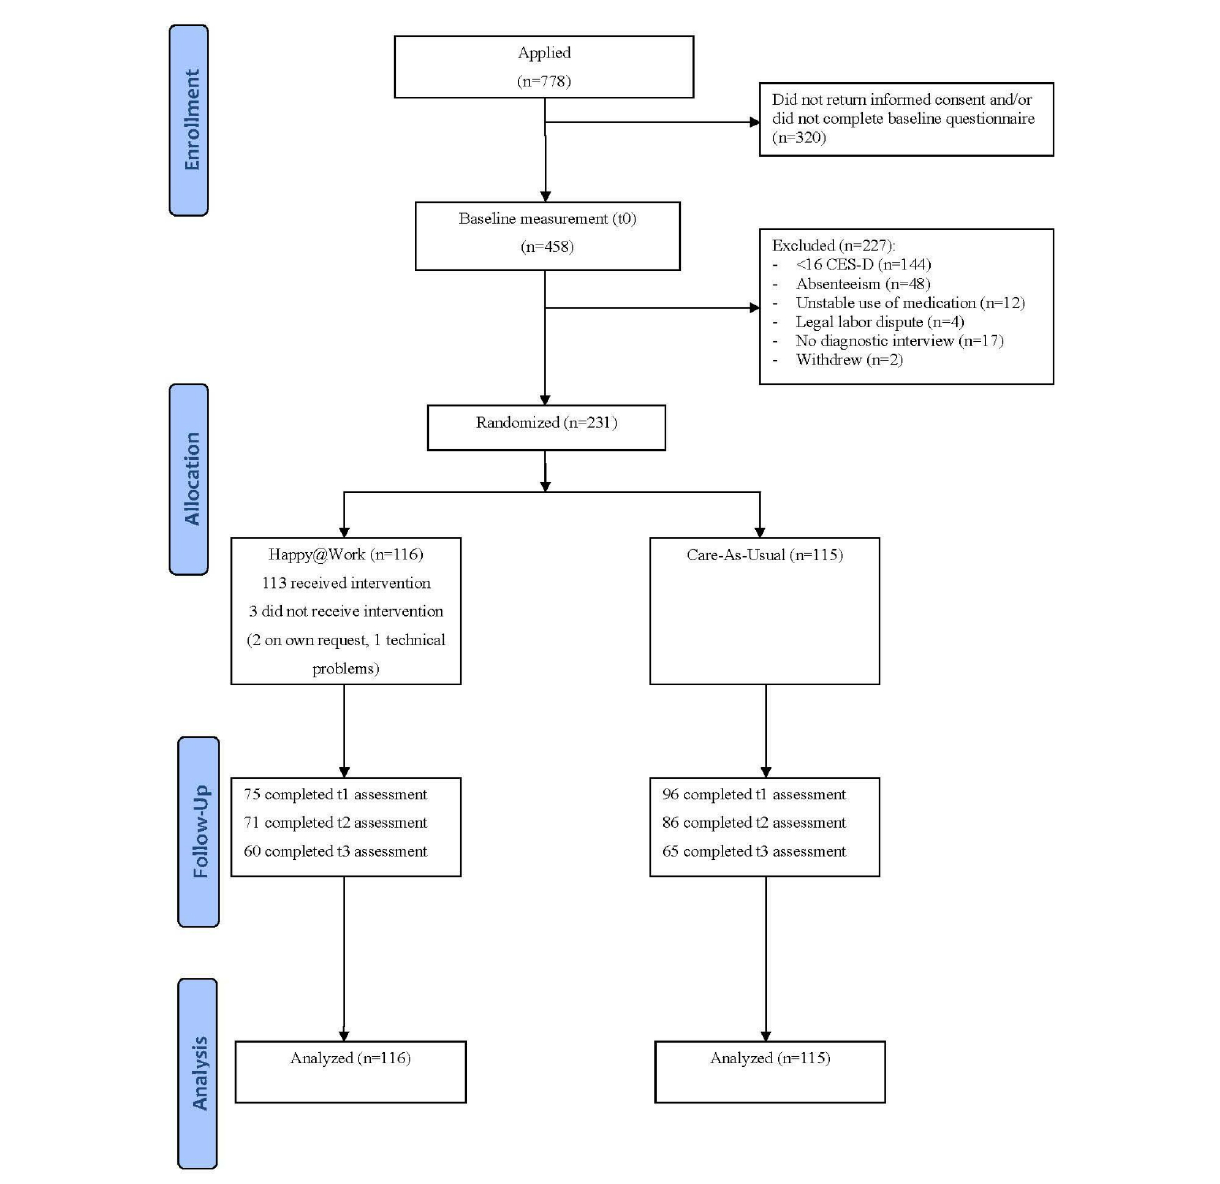
Figure 1. Flowchart of